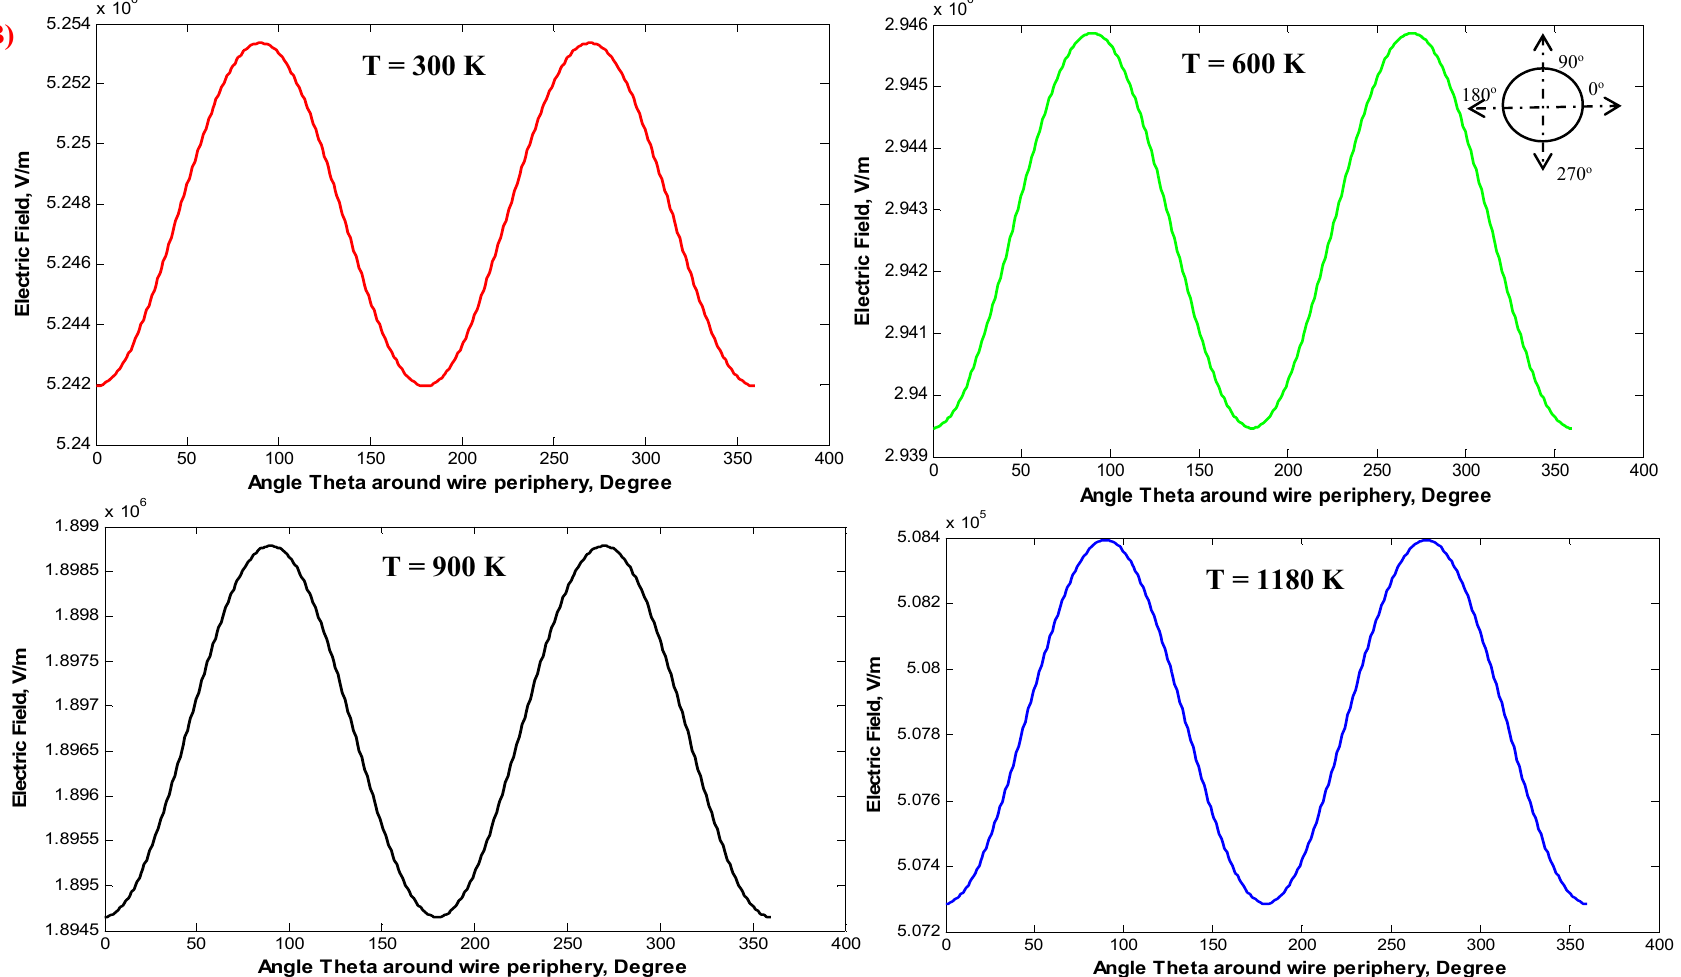
Figure 15. Distribution of the electrostatic field around the central wire of the multi-discharge wire WDESP (three-wire): ( A ) r c = 0.935 mm, V o = 36.424 kV; and ( B ) r c = 1.975 mm, V o = 57.464 kV.